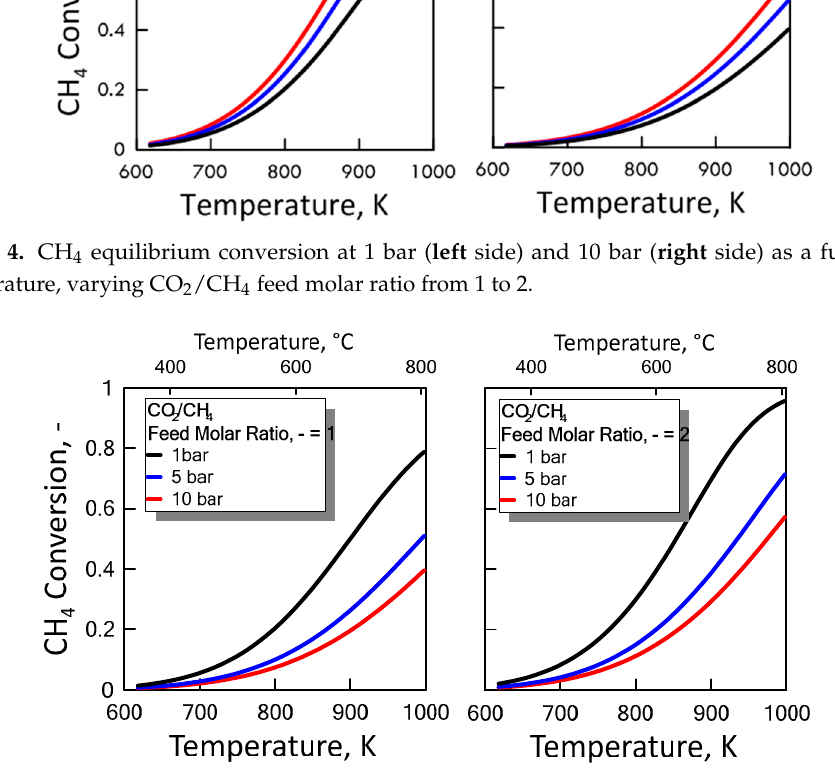
Figure 5. CH 4 equilibrium conversion at CO 2 /CH 4 feed molar ratio of 1 ( left side) and 2 ( right side) as a function of temperature, varying the pressure from 1 to 10 bar.